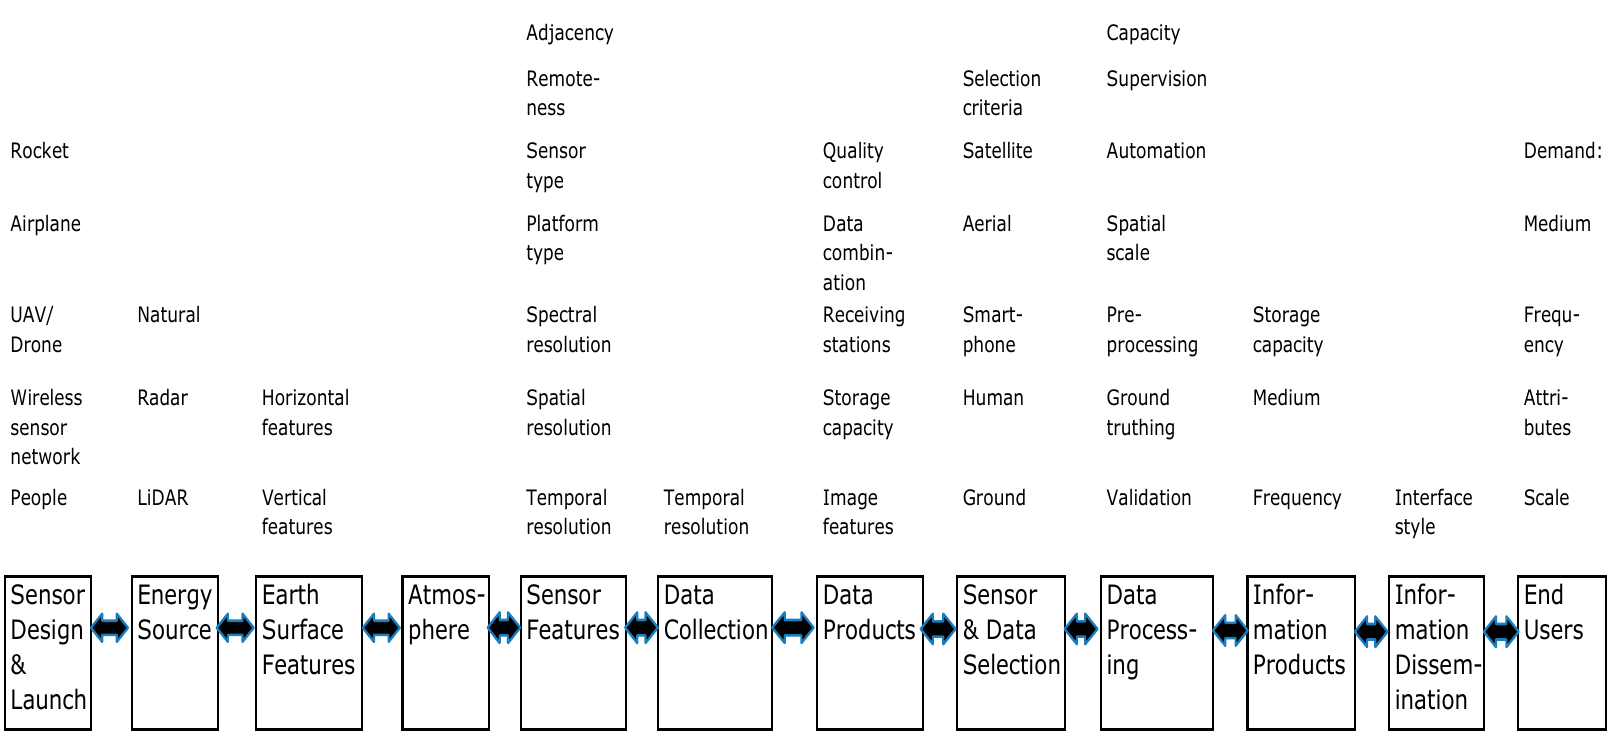
Figure 3. The Conceptual Framework for Earth Observation, showing possible parameters for each component.